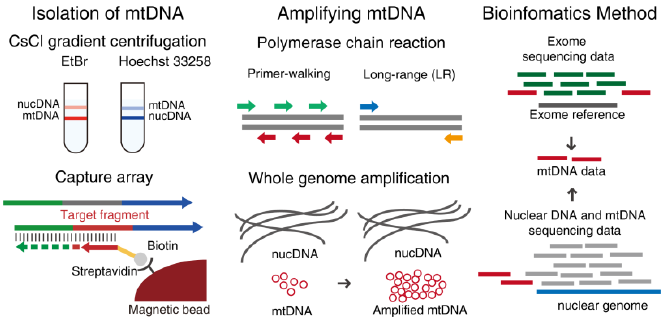
Figure 2. A brief schematic diagram of enriching methods for mtDNA. Isolation methods separate or capture mtDNA from specimen directly, which need abounding biospecimen. Amplifying mtDNA